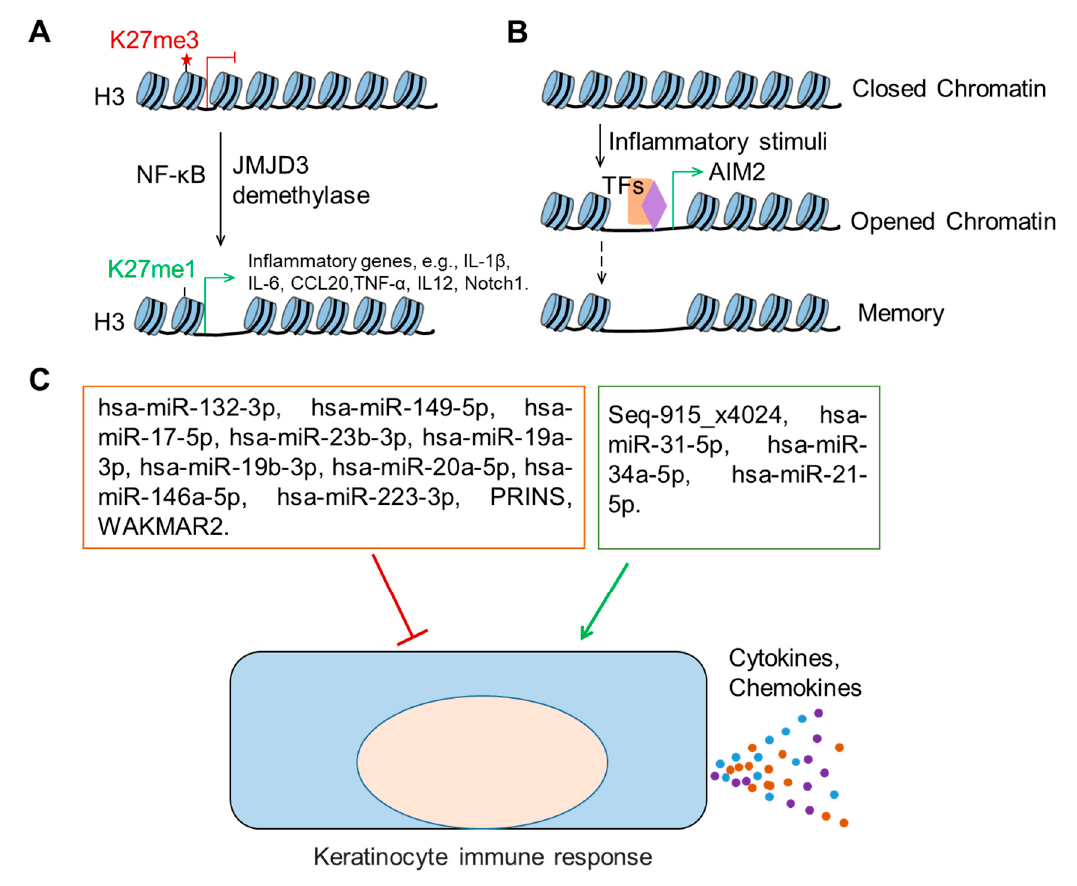
Figure 3. Epigenetic regulation of keratinocyte immune functions in wound healing. ( A ), The H3K27me3 demethylase Jumonji domain containing-3 (JMJD3), cooperating with the nuclear factor kappa-light-chain-enhancer of activated B cells (NF- κ B), activates the expression of several inflammatory genes, including interleukin 1 beta (IL-1 β ), interleukin 6 (IL-6), chemokine (C-C motif) ligand 20 (CCL20), tumor necrosis factor (TNF- α ), interleukin 12 (IL12), and Notch1 that is a crucial transcription factor in skin development and homeostasis. ( B ), Inflammatory stimuli trigger the chromatin opening in epithelial stem cells. After the resolution of inflammation, the chromatin accessibility is maintained for several critical inflammatory response genes, such as absent in melanoma 2 (AIM2), allowing the rapid transcription of AIM2 upon secondary stimulus. ( C ), Noncoding RNAs regulate keratinocyte immune response. The noncoding RNAs in the red frame negatively regulate cytokine or chemokine secretion in keratinocytes, while the ones in the green frame positively regulate